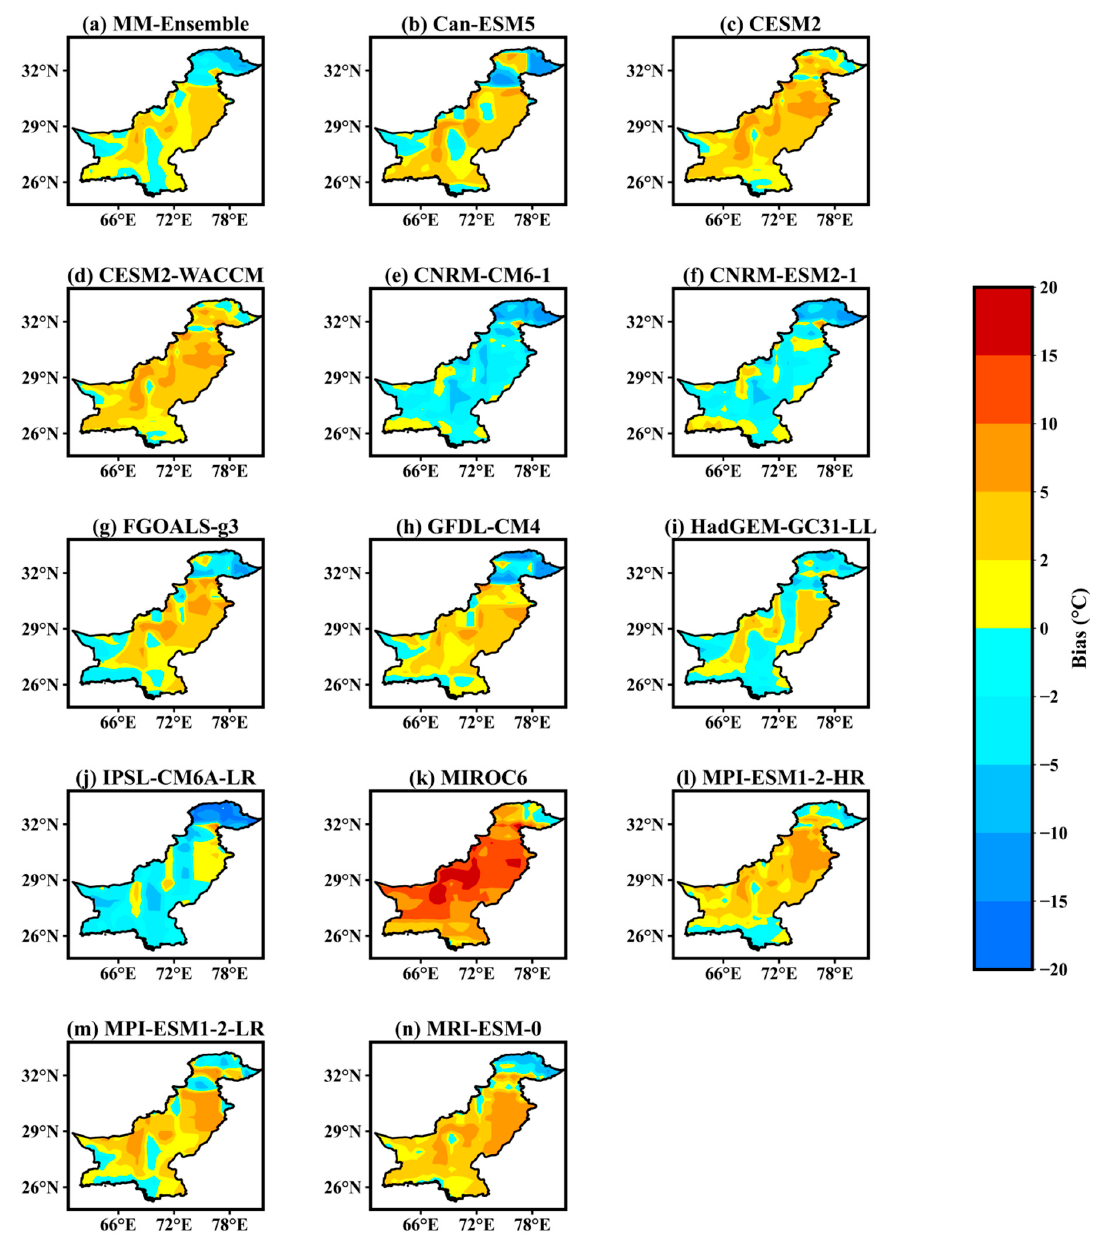
Figure 10. Spatial bias distribution of JJA mean temperature ( °C ) over Pakistan for 1970–2014 by ( a ) MM-Ensemble, ( b ) Can-ESM5, ( c ) CESM2, ( d ) CESM-WACCM, ( e ) CNRM-CM6-1, ( f ) CNRM-ESM2-1, ( g ) FGOALS-g3, ( h ) GFDL-CM4, ( i ) HadGEM-GC31-LL, ( j ) IPSL-CM6A-LR, ( k ) MIROC6, ( l ) MPI-ESM1-2-HR, ( m ) MPI-ESM-2-LR, and ( n ) MRI-ESM-0.